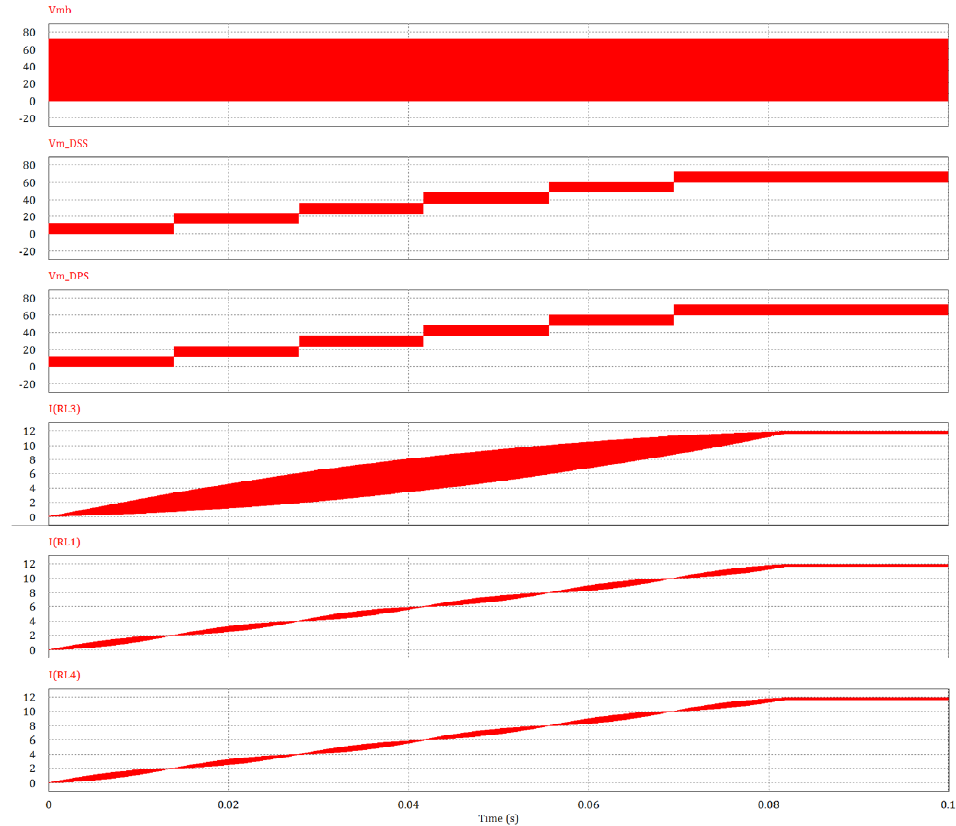
Figure 12. Comparison between the operational output characteristics of the existing converter and proposed converter.